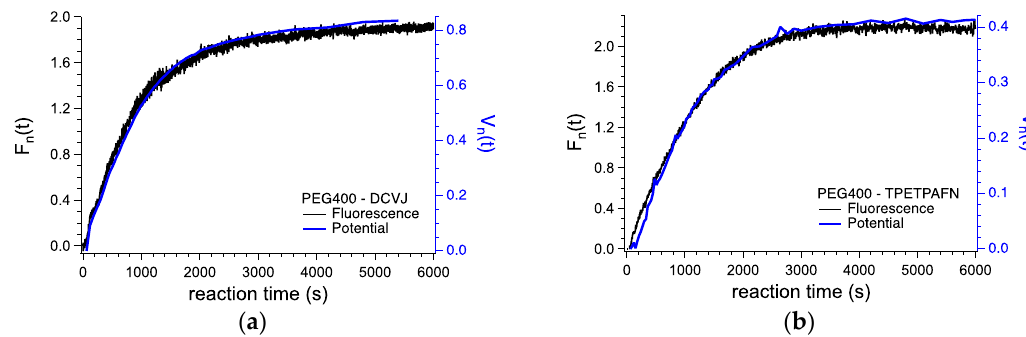
Figure 5. Relative fluorescence variations ( F n (t) , solid line) for the synthesis of PU in the presence of ( a ) DCVJ ( λ exc = 430 nm, λ em = 510 nm) and ( b ) TPETPAFN fluorescent probes for PEG400 as a diol and the corresponding relative potential variations ( V n (t) , blue curve) acquired by the sensing system based on the photodiode ( λ exc = 470 nm in both cases).